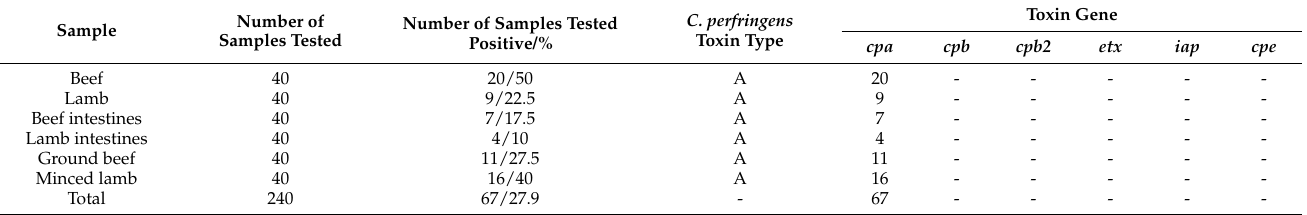
Table 1. Detection of Clostridium perfringens isolates and associated genes in examined meat products ( n = 240) from meat fairs ( n = 4) in four areas in west Kazakhstan.